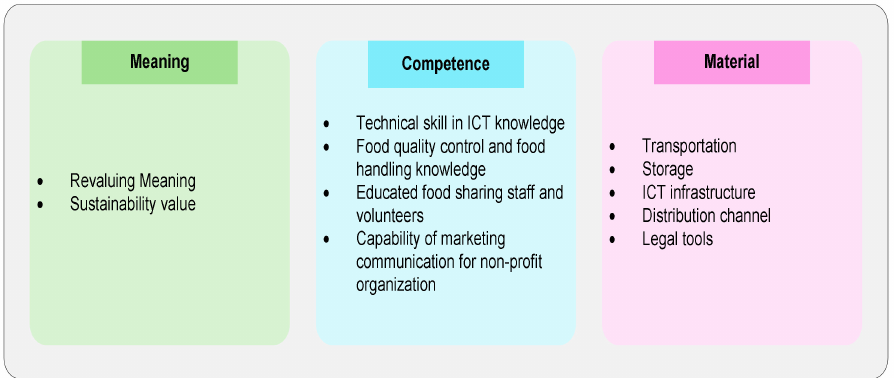
Figure 6. Food Sharing from the perspective of Social Practice